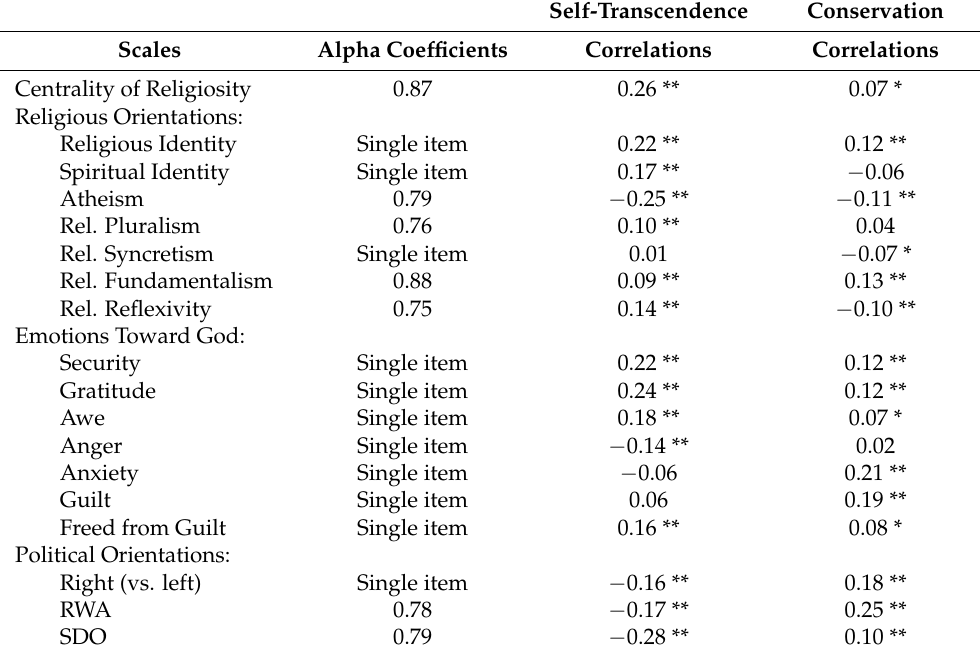
Table 1. Alpha coefficients and correlations of the applied scales with self-transcendence vs. self- enhancement and conservation vs. openness to change ( n = 824 to